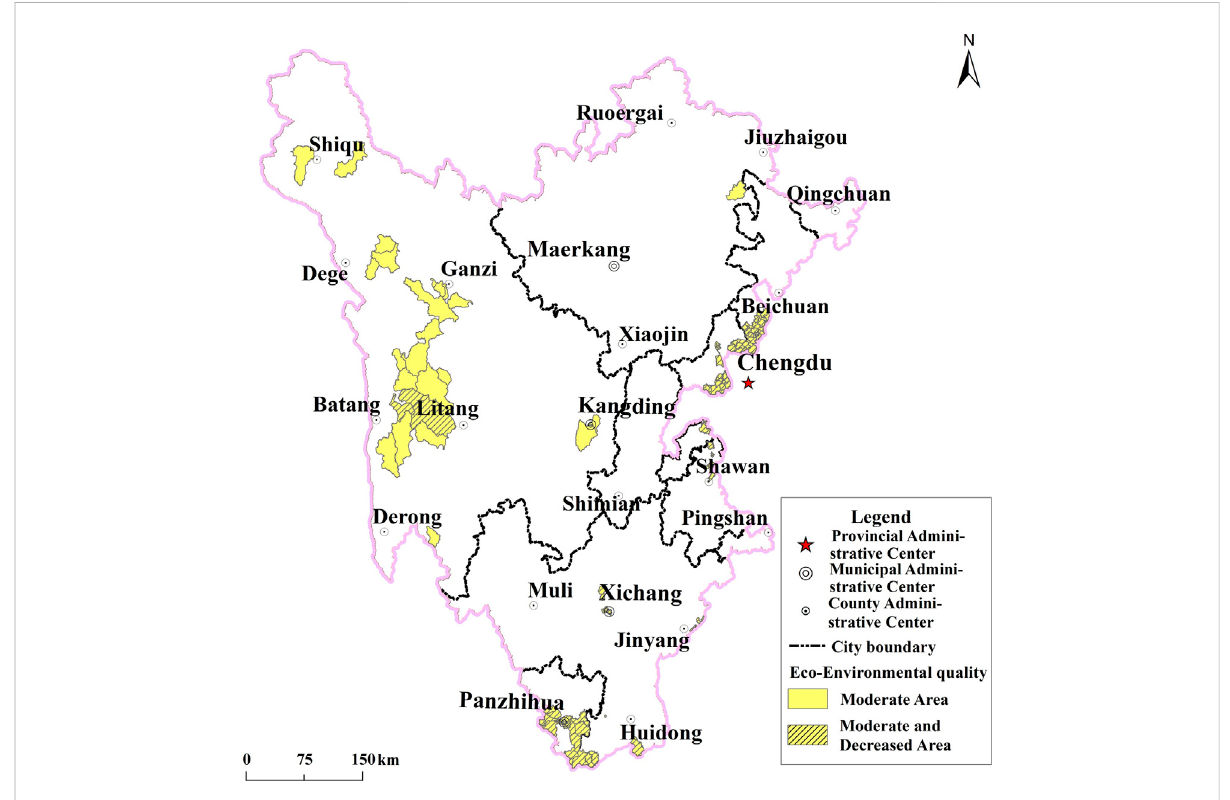
FIGURE 11 Moderate Eco-environmental quality and obvious degradation